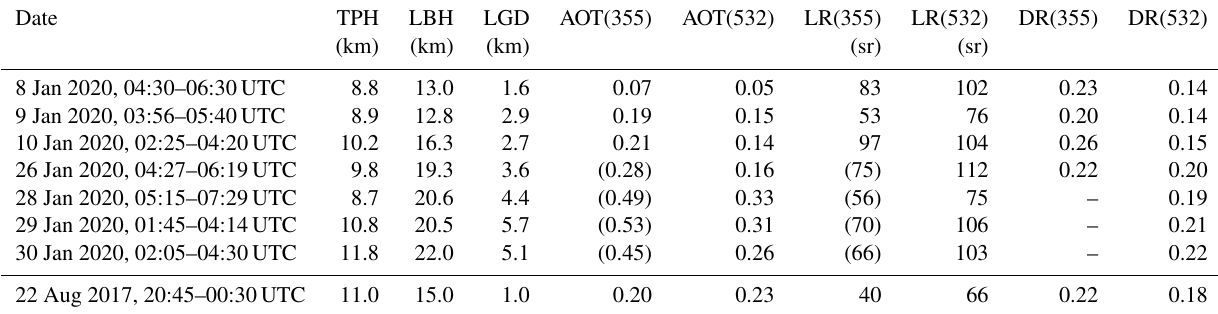
Table 1. Smoke layer mean values of lidar ratios (LR) and depolarization ratios (DR) simultaneously measured at 355 and 532nm on 3 sub- sequent days in January 2020. Tropopause height (TPH), layer base height (LBH), geometrical depth (LGD), and AOT of the stratospheric smoke layers are given in addition. Wavelength (in nm) is indicated in parentheses. The uncertainty in the layer mean values is mainly caused by signal noise estimated to be about 10% (DR, 532nm), 20% (LR, 532nm, DR, 355nm), and 30% (LR, 355nm). For comparison, values for aged Canadian smoke measured over Leipzig, Germany, in August 2017 are given in the last line (Haarig et al., 2018). AERONET photometer observation of AOT wavelength dependence for the short wavelength spectral range (380–500nm) is used to estimate 355nm smoke AOT, extinction coefficient, and lidar ratio from the lidar measurements at 532nm. These value are also given in parentheses (26–